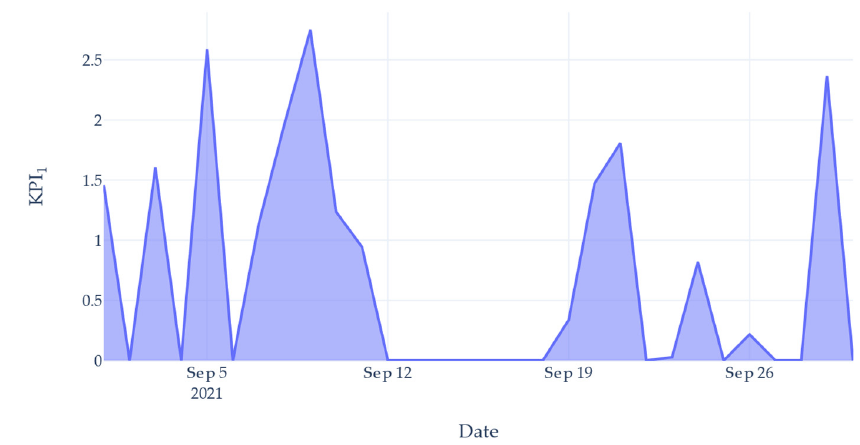
Figure 9. KPI 1 —parts per cubic meter of Figure 9. 𝐾𝑃𝐼 1 —parts per cubic meter of gas.